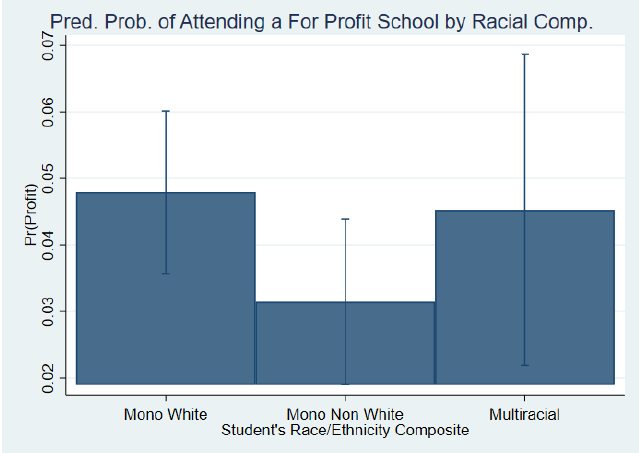
Figure 4. Pred. Prob. of Profit v Not for Profit Choice by Racial Comp. using ELS data.